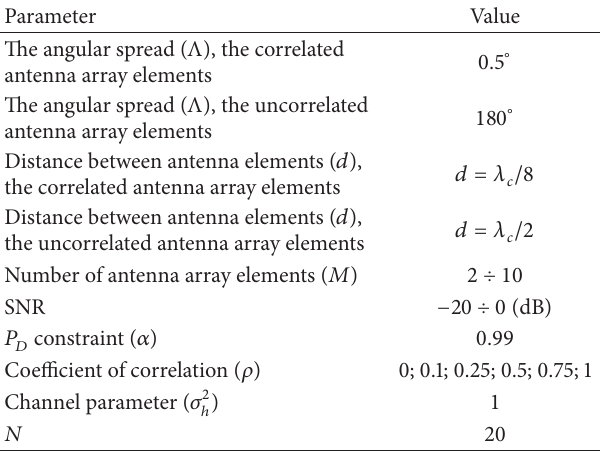
Figure 3: Comparison between the ED and GD sensing perfor- mance. Table 1: Simulation parameters.